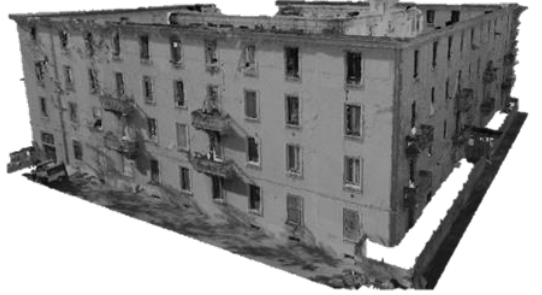
Figure 2. 3D point cloud survey with Cyclon 360. Figure 3. Euclideon Hologram